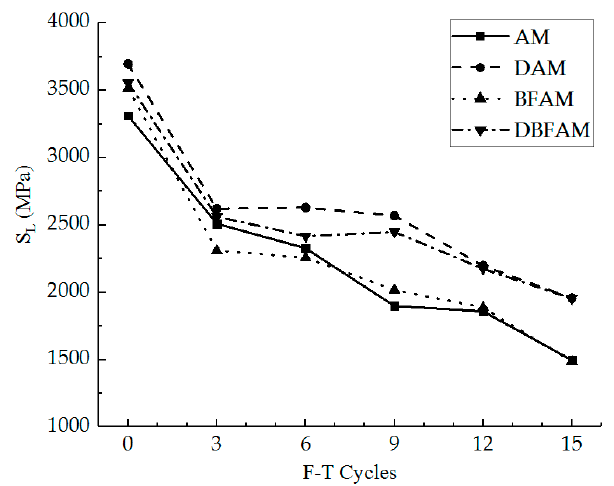
Figure 16. Elastic stiffness modulus of linear zone under F–T cycles.